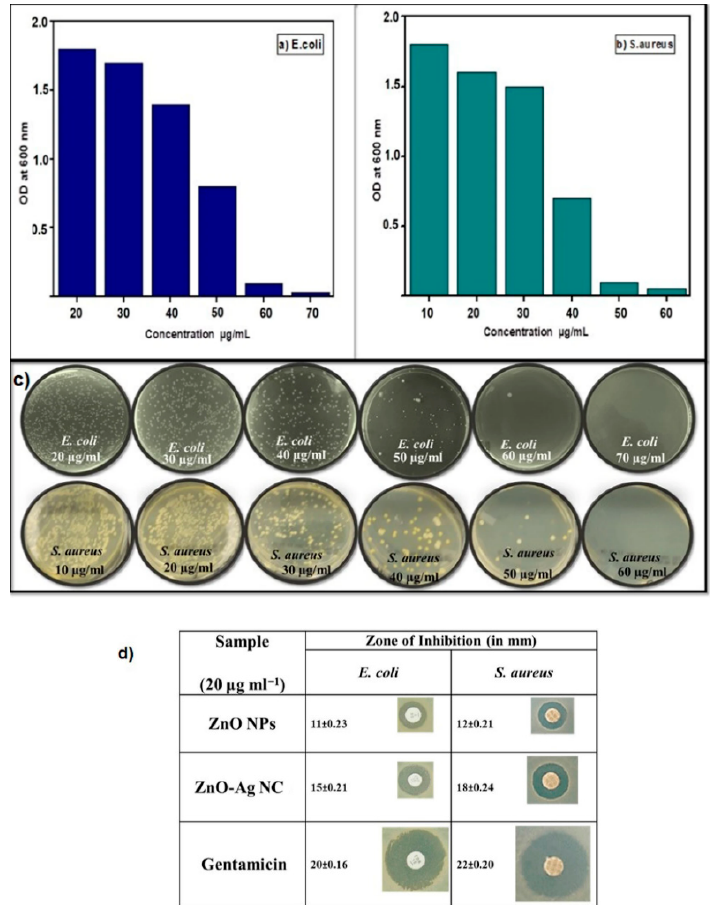
Figure 27. Effect of AgNPs/ZnO concentrations on the viability of ( a ) E. coli , ( b ) S. aureus , and ( c ) bacterial colony features cultured on agar plates. ( d ) Inhibition zone of AgNPs/ZnO nanocomposite (NC), ZnO NPs and Gentamicin. Gentamicin is an antibiotic specifically used for treating bacterial infections. OD in ( a ) denotes optical density. Reproduced from [282] under a Creative Commons Attribution 4.0 International